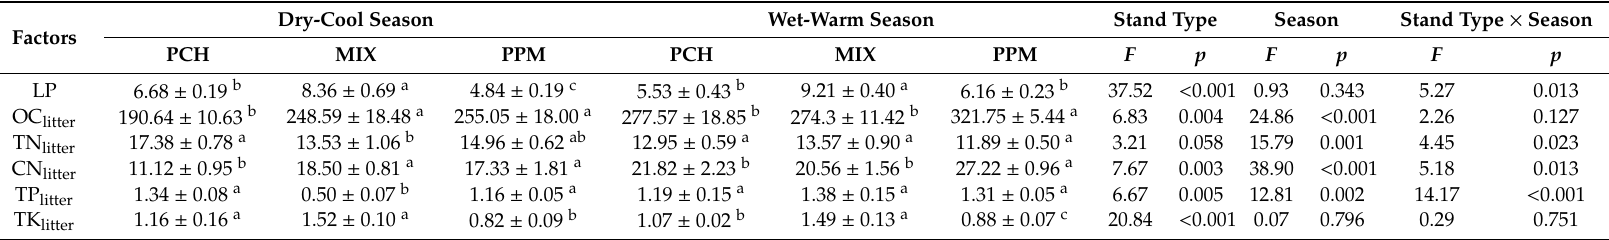
Table 2. The quantity and quality of litter in pure Castanopsis hystrix (PCH) plantation, pure Pinus massoniana (PPM) plantation, and mixed C. hystrix and P. massoniana (MIX) plantation (mean ± standard error; n = 5).